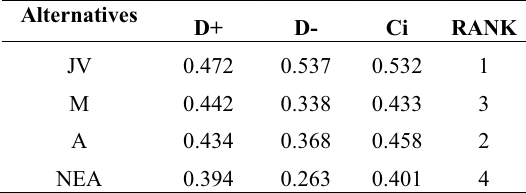
Table 16: Separation values and relative closeness of